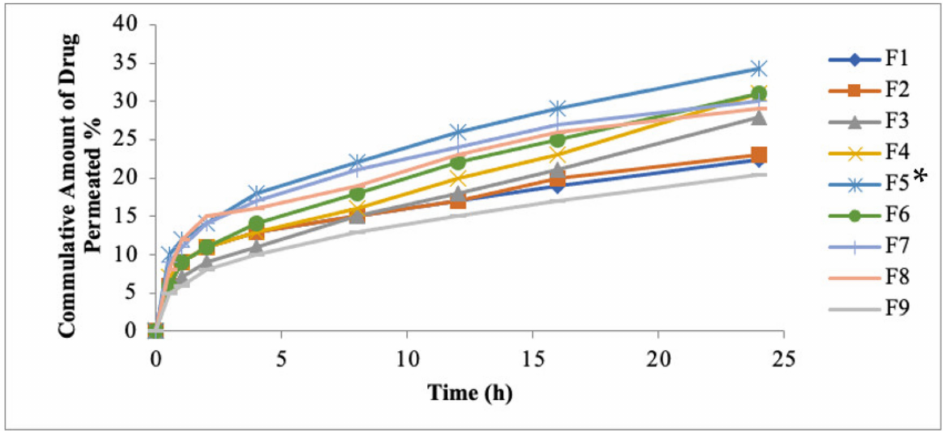
Figure 4. Ex vivo permeation of MTX patches. Data are expressed as mean ± SD; n = 3. One-way ANOVA followed by post hoc Tukey test ( p < 0.05), F5 vs. F1. (* p <